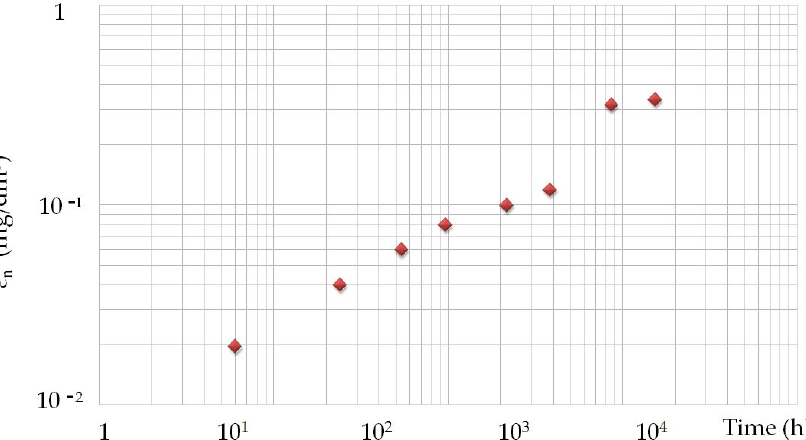
Figure 11. Total leachability of barium from the opoka rock over time. ♦ —average leachability of Ba from opoka rock (mg/dm 3 ).